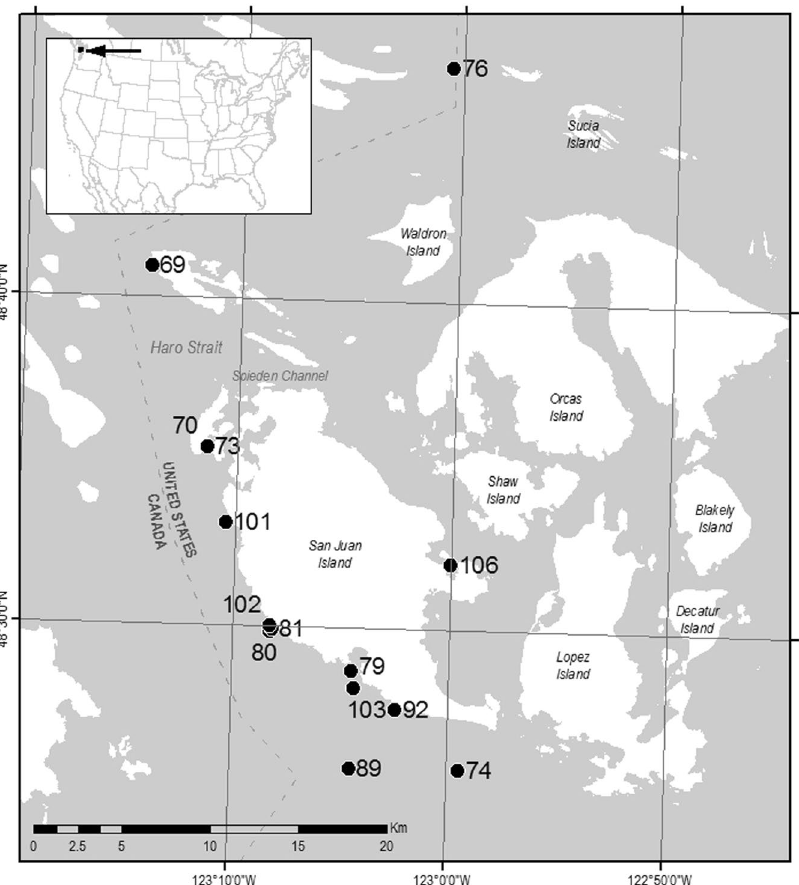
Figure 1. Map of study area displaying locations of waypoints for SML sampling, and the relationship of the study area to the continental US (inset). Map with waypoints were generated by B. Sylvander (NOAA Fisheries) using ESRI ArcGIS Desktop 10.3.1 (http://desktop.arcgis.com/en/arcmap/10.3/main/get-started/whats-new-in-